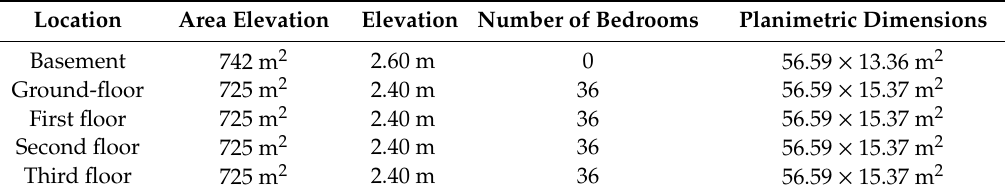
Table 1. Main geometrical characteristics of each